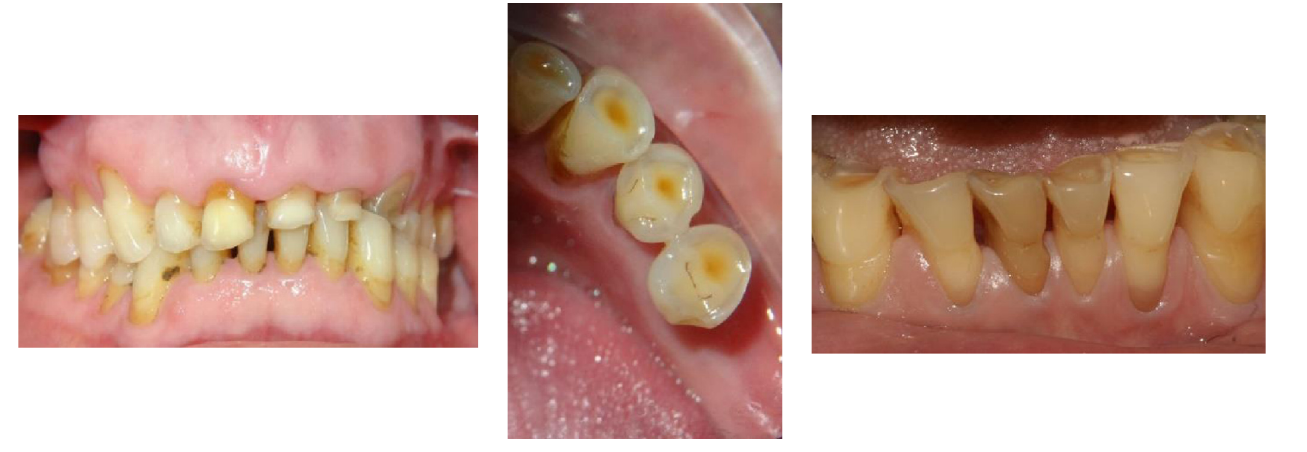
Fig. 1. Clinical results of bruxism in